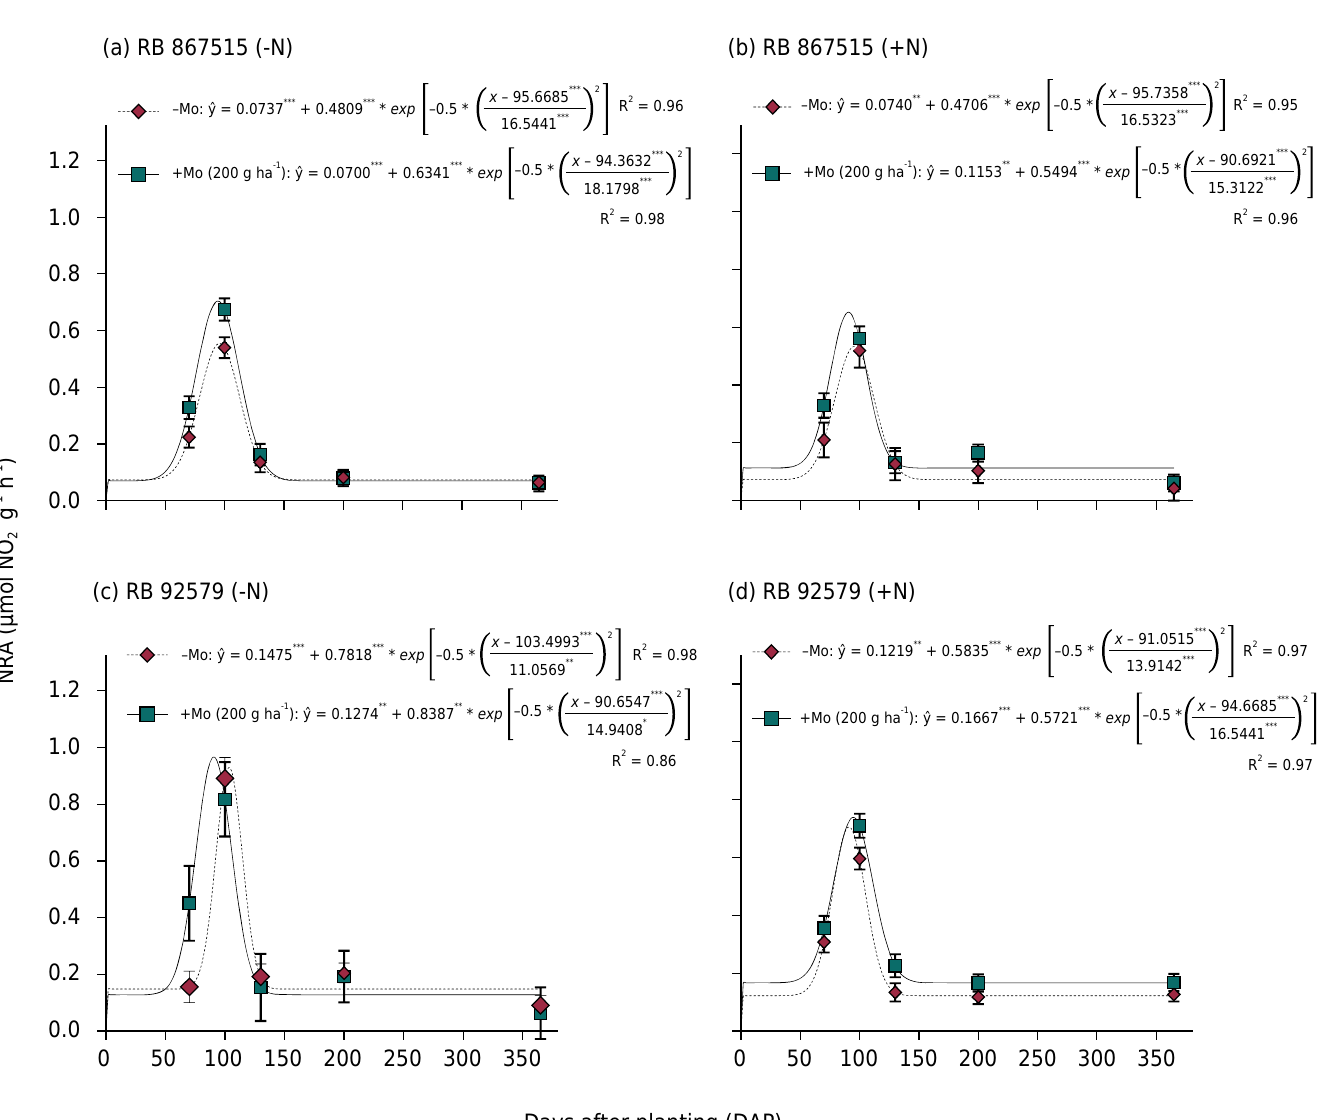
Figure 1. Nitrate reductase activity (NRA) in the leaves of sugarcane - Mo and +Mo (200 g ha -1 ) fertilization for the variety RB 867515, -N and +N (60 kg ha -1 ) fertilization (a and b, respectively), and for the variety RB 92579, -N and +N fertilization (c and d, respectively) at 70, 100, 130, 200, and 365 days after planting